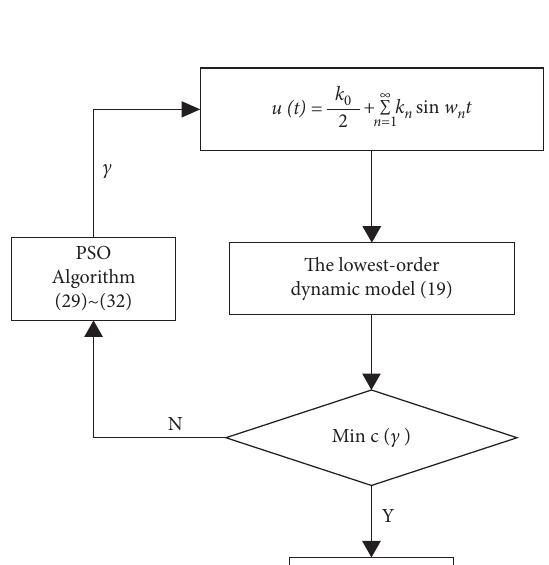
Figure 9: Trapezoidal signal.